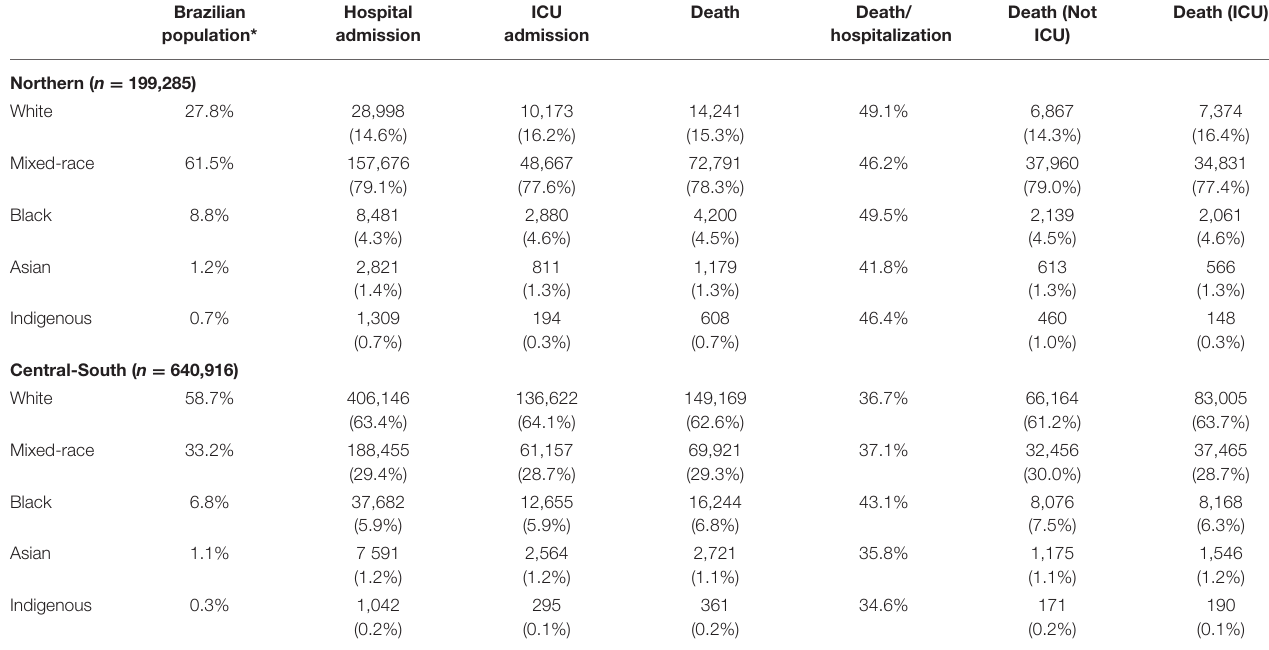
TABLE 2 | Ethnic characteristics of patients at each stage of hospitalization from COVID-19. Brazilian population*